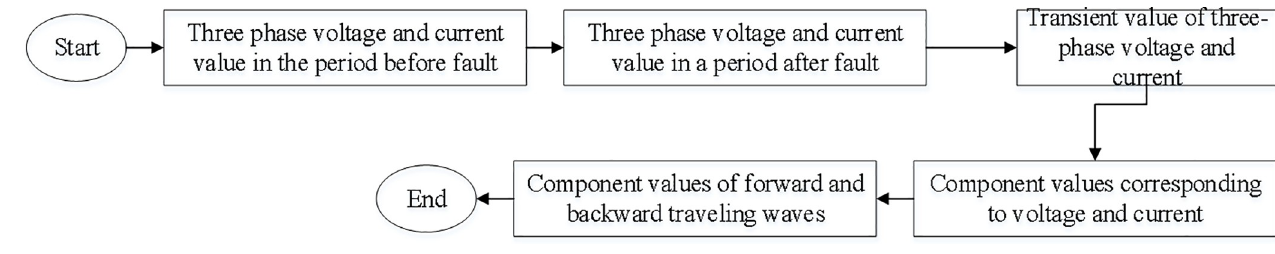
Fig 6. Fault traveling wave’s extraction process.